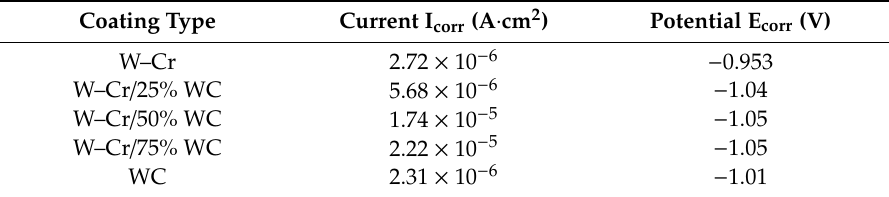
Figure 12. Corrosion resistance tests results of coatings produced using laser processing of different precoats applied on steel substrate. Table 3. Corrosion current and corrosion potential of composite coatings produced using laser processing of precoat.